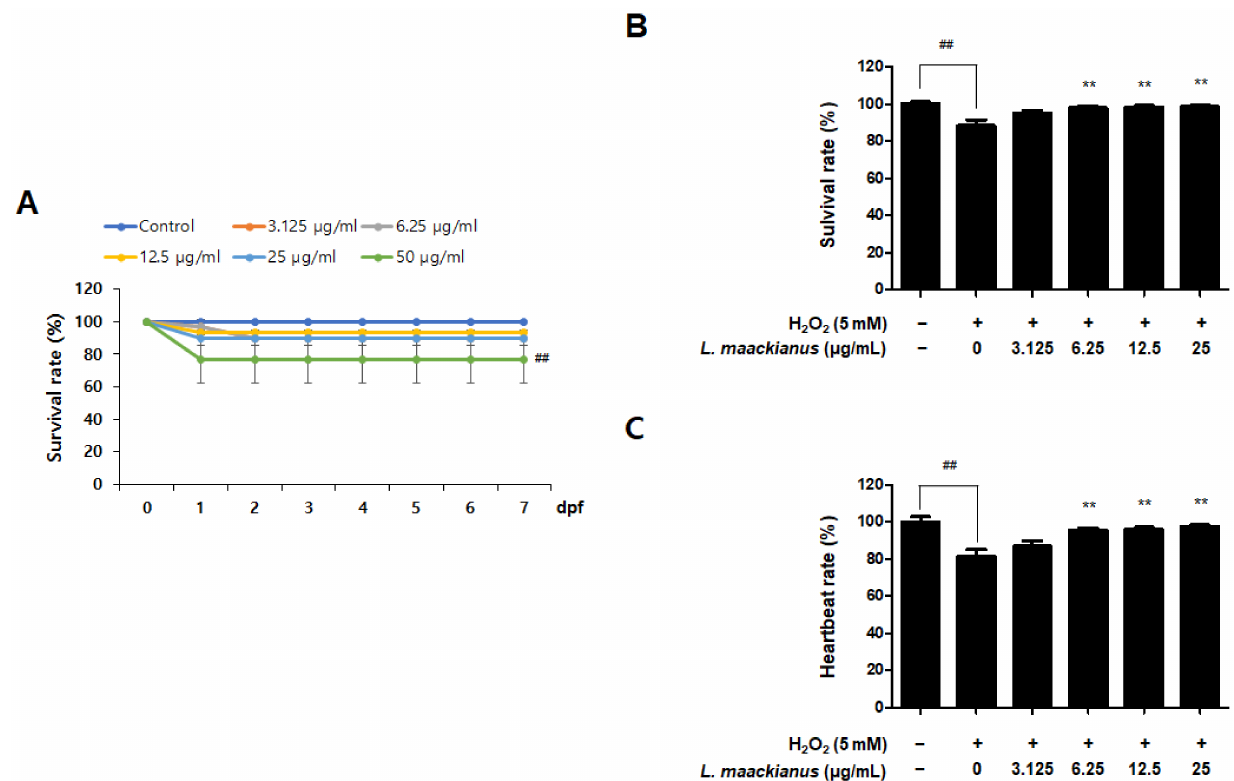
Figure 7. Toxicity evaluation ( A ) and hydrogen peroxide (H 2 O 2 )-induced oxidative toxicity